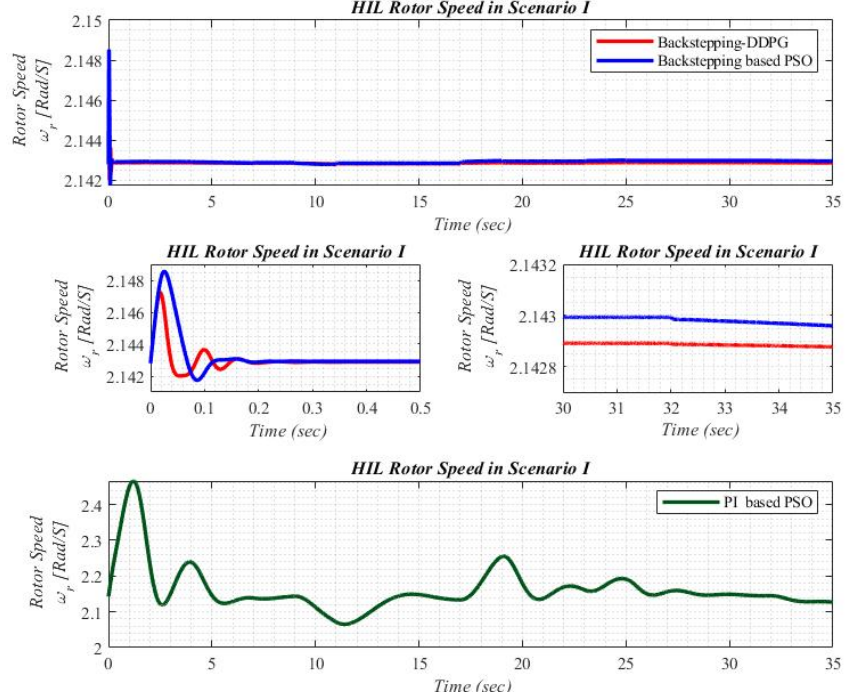
Figure 7. HIL output comparative results of backstepping controller based DDPG in combination with model free control (MFC), backstepping and PI controllers optimized by PSO according to Scenario I .